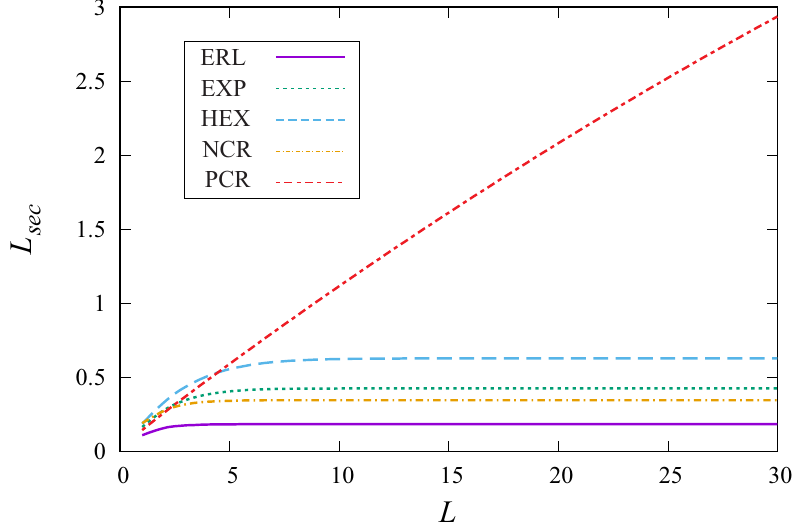
Figure 3. Dependence of the average number of customers with the secondary server L sec on the parameter L for different MAP